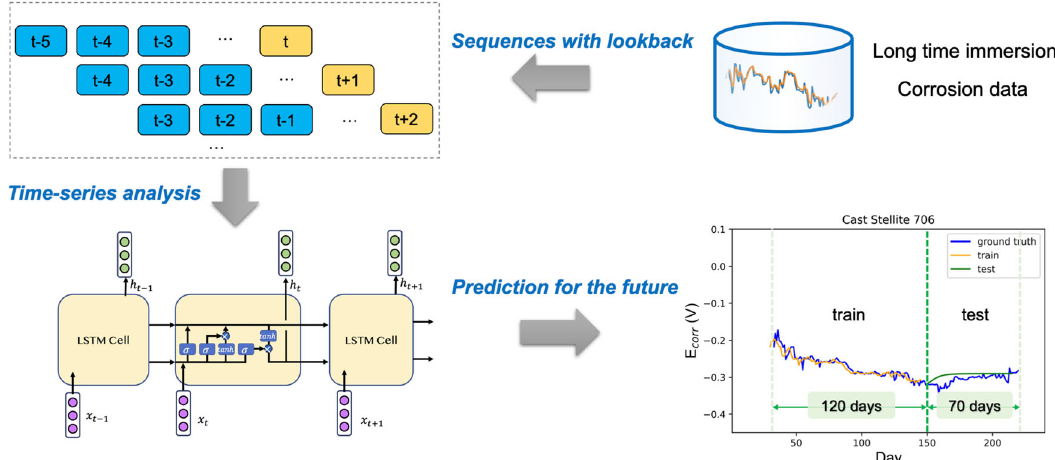
Fig. 1 The work fl ow diagram of machine learning. The collected dataset are transformed into sequences with appropriate lookback to maintain the information of former moment. Then LSTM neural network is trained to capture the dependences, and it is fi nally used to conduct future prediction for the following days ’ pitting.